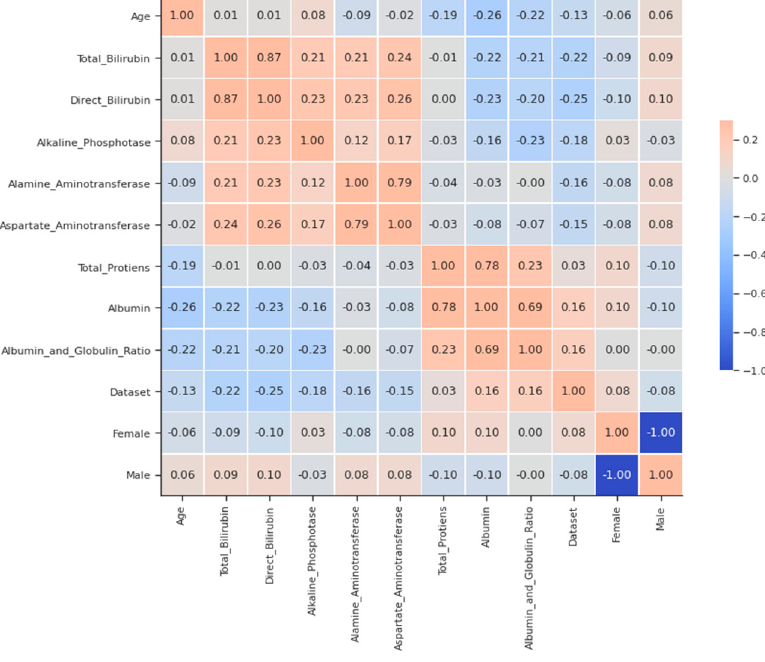
Figure 1. Simple Correlation Plot- liver disease.